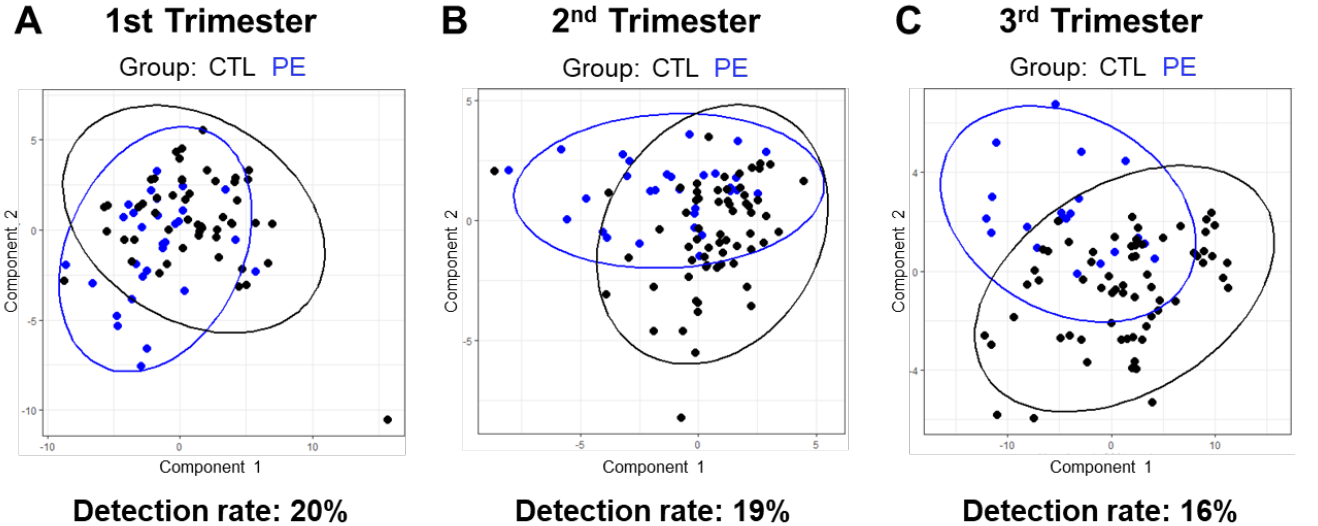
Figure 4. Lipidome-based PE prediction using supervised sparse partial least squares discriminant analysis. ( A – C ) Lipidomic data projected onto the first and second components of an sPLS-DA model built using data from each of the indicated trimesters. Ellipses indicate the 95% confidence interval of each group. The PE detection rate for each trimester-specific model is shown below its corresponding plot.